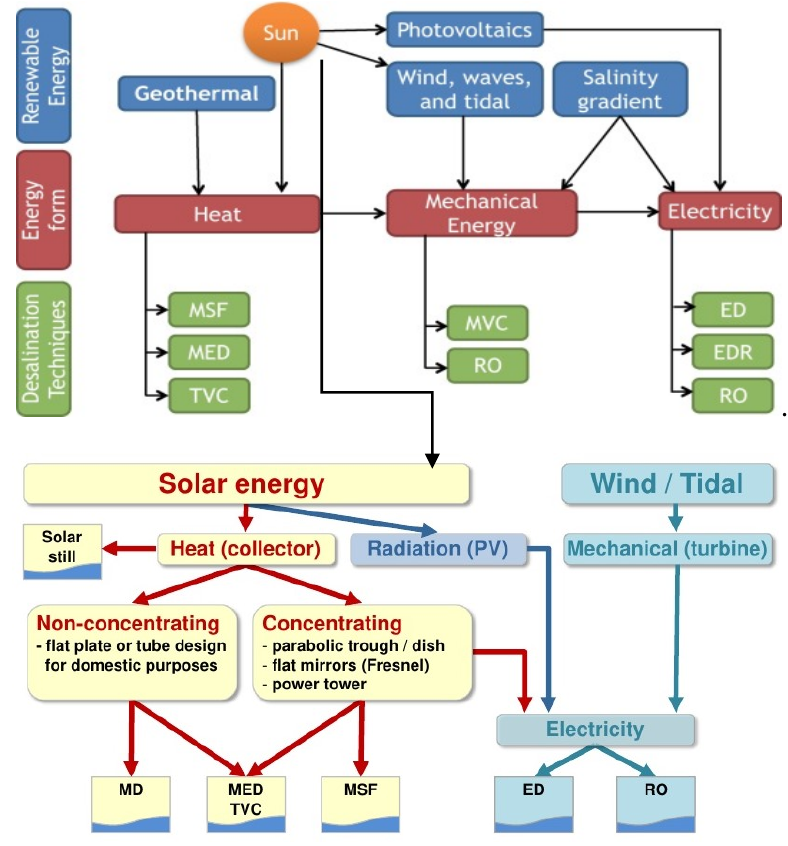
Figure 8. Renewable energy integration with various desalination technologies [52].